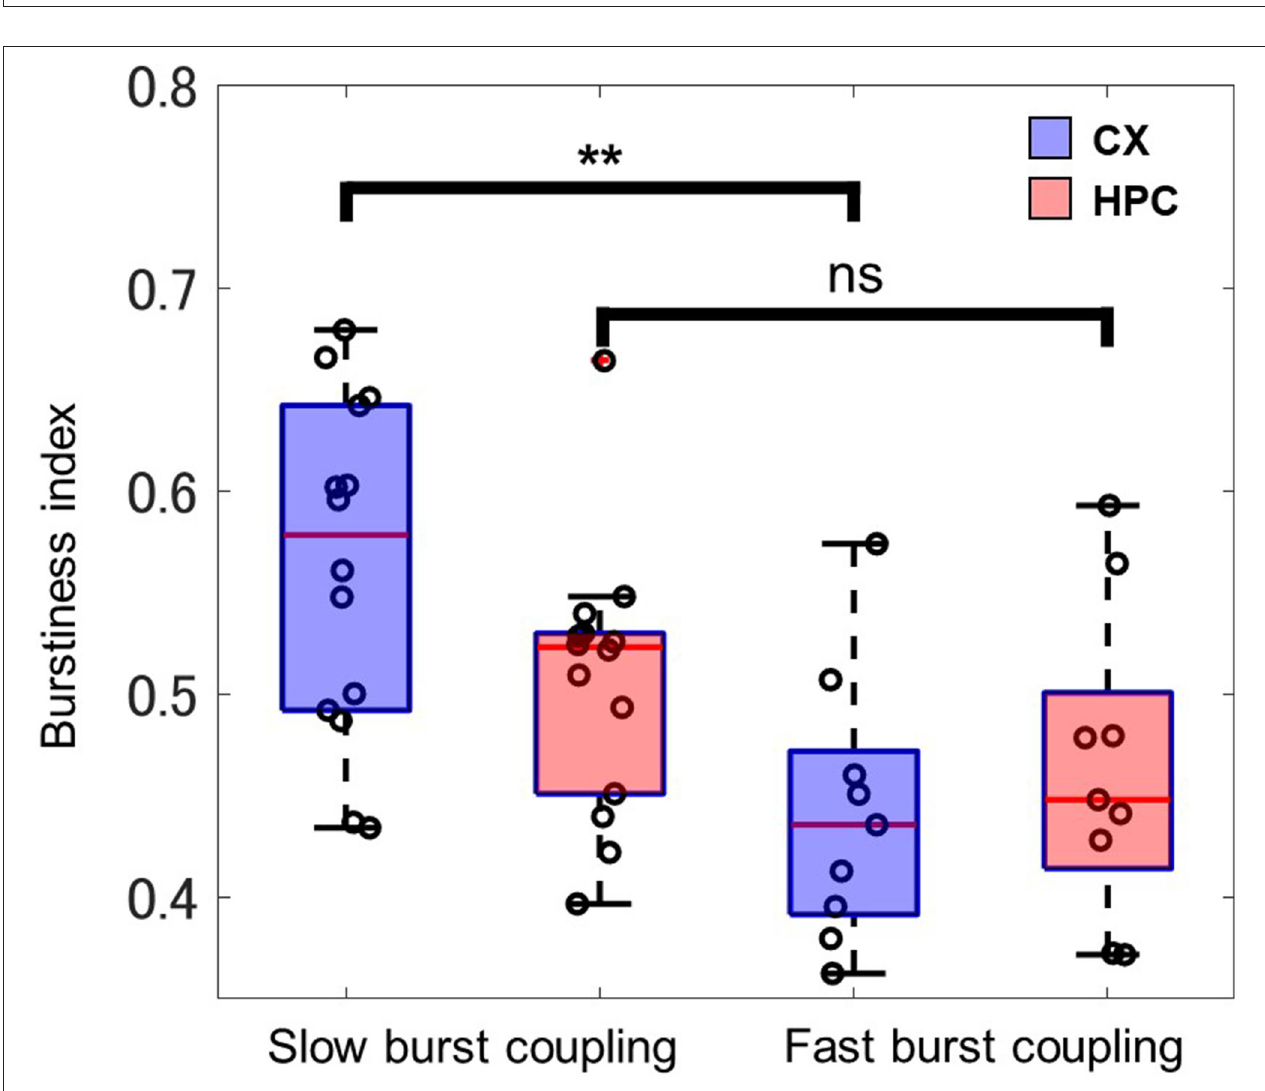
FIGURE 6 | band. The HPC network in (B) shows two peaks in the delta and high-gamma bands, respectively. The HPC network in (D) shows two peaks, in the theta and high-gamma bands, respectively. (E) Shows a heatmap of the CX part, and ( F ) shows a heatmap of the HPC part of both samples. Corresponding rows in (E,F) show the CX and HPC parts of the same sample. Two patterns of frequency coupling are observed, separated by a black dotted line in the heatmaps. These are (1) slow-wave and gamma in CX, with concurrent delta and high gamma in HPC (2) and low gamma in CX, with concurrent theta and high gamma in HPC. (G,H) Show the average ISI distributions of the two classes of samples defined by their patterns of frequency coupling. Solid lines and shadowed areas represent the average and standard error, respectively. (G) Shows the average ISI distribution of neocortical spike activity. (H) Shows the average ISI distribution of hippocampal spike activity. Dark blue and red lines represent the first mode of activity coupling (slow-wave and gamma in CX, and delta and high gamma in HPC). Light blue and yellow lines represent the second mode of activity coupling (low gamma in CX, and theta and high gamma in